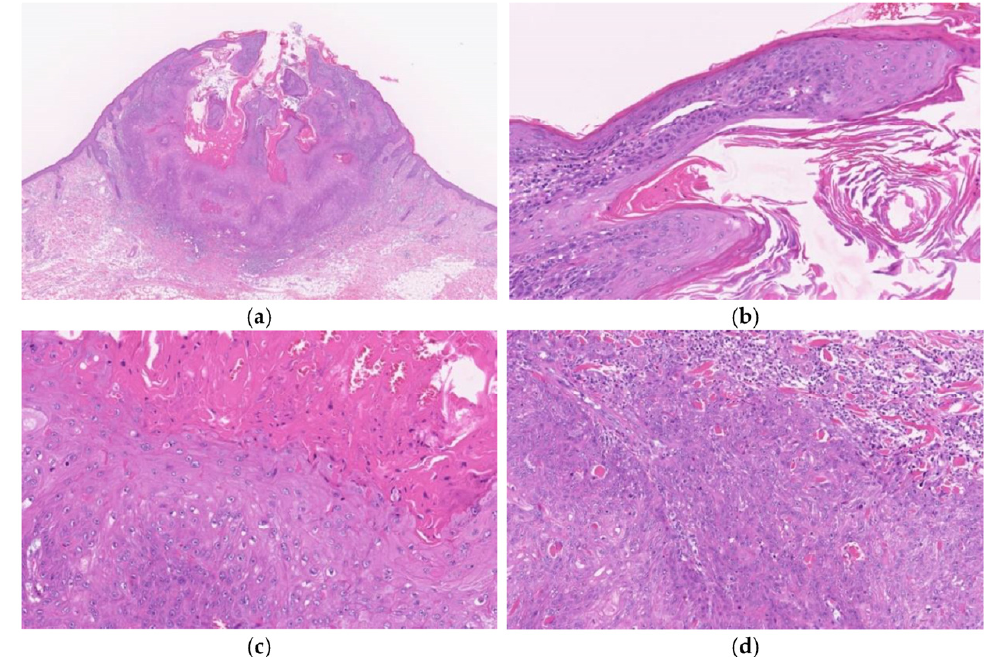
Figure 2. Histopathological findings of KA at the early/ proliferative stage. Gross findings of the lesion include crateriform architecture with a central keratinous plug ( a ). A lip-like structure is observed ( b ). Pale pink keratinocytes with a glassy appearance are observed. In the deeper areas, pale pink keratinocytes with a glassy appearance are noted ( c ). The deeper areas of the lesion are poorly demarcated from the surrounding stroma and exhibit slightly invasive growth ( d